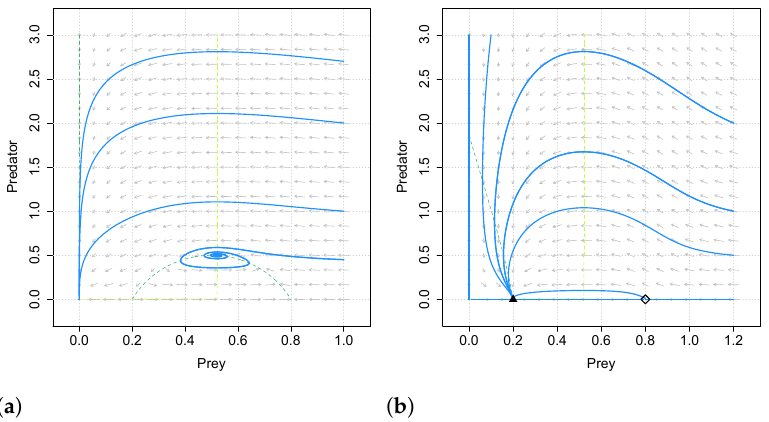
Figure 9. Dynamic behaviors with r = 2, K = 0.2, m = 0.8, s = 1, a = 1.2, α = 0.8, n = 0.5 and η = 0.8. ( a ) Possible coexistence in system (27). ( b ) Extinction of predators in system